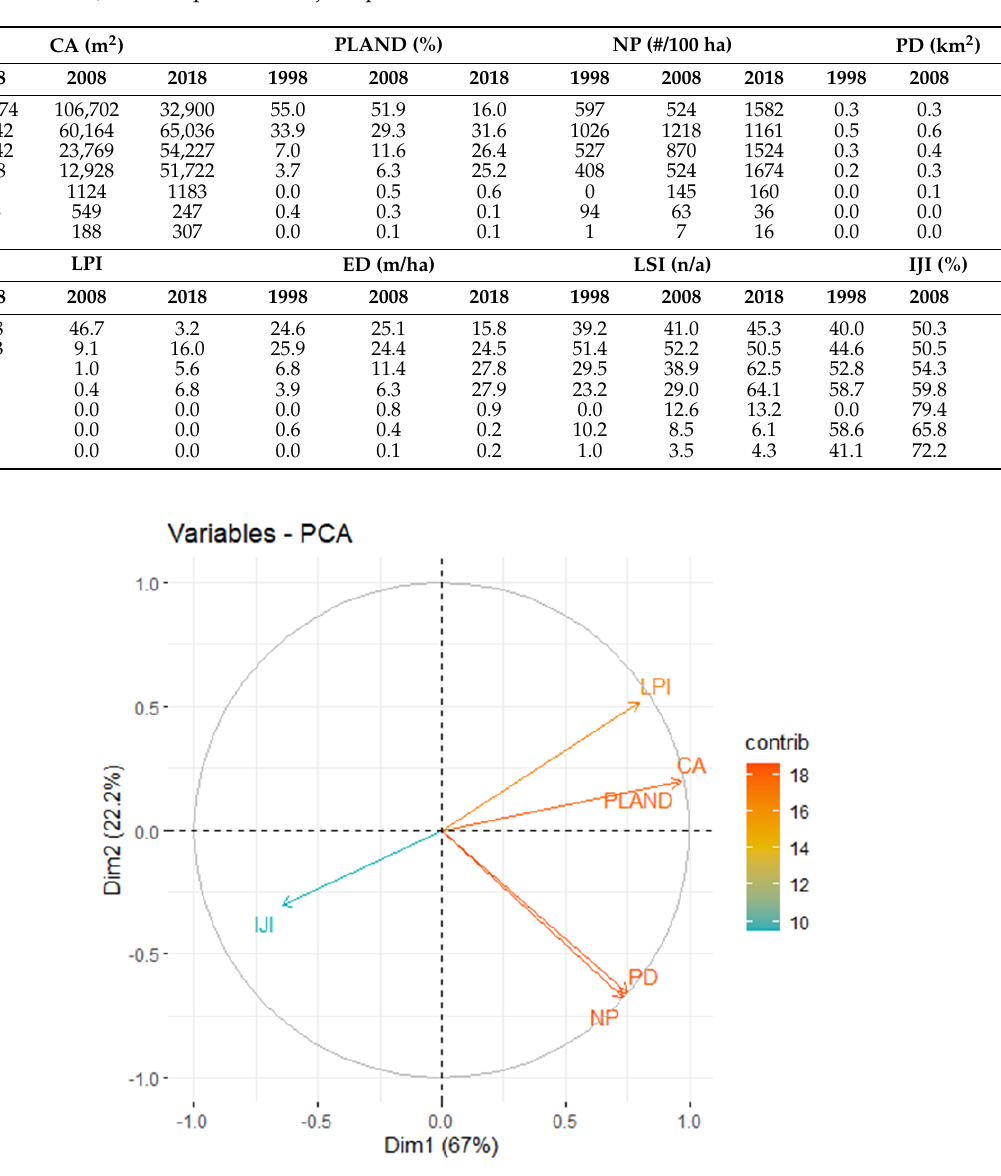
Figure A1. Variable distributions and their according contributions based on Principal Component Analysis (PCA) in Wami Mbiki – Saadani wildlife corridor, Tanzania, toward our landscape analysis. Contrib = contribution, LPI = largest patch index, CA = total class area, PLAND = percentage of landscape, PD = patch density, NP = number of patches, IJI = interspersion and juxtaposition index. The color ramp indicates the variable contribution importance to PC1 (Dim1) and PC2 (Dim2).